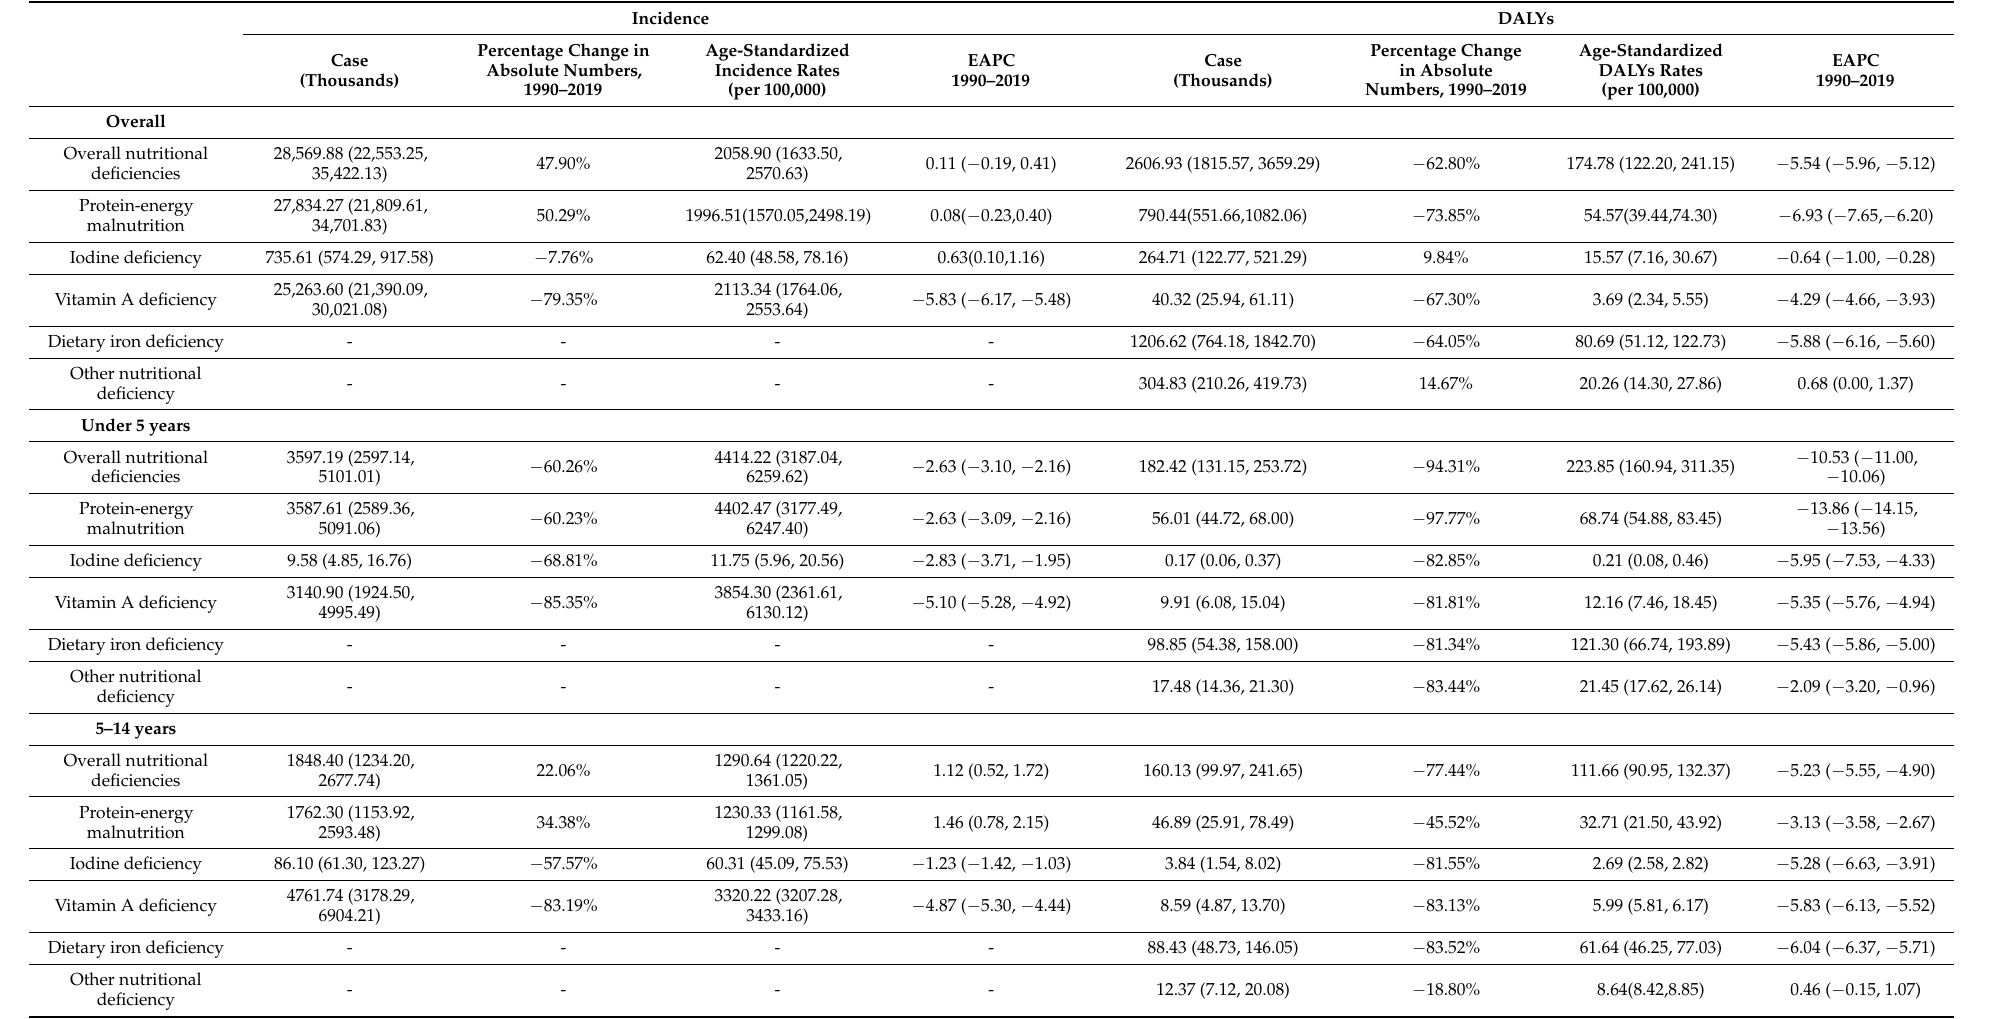
Table 1. The number, age-standardized rates of incidence, and DALYs and their estimated annual percentage changes (EAPC) from 1990 to 2019 across ages and age groups for nutritional deficiencies and its main subcategories in China. DALYs = disability-adjusted life-years. Incidence